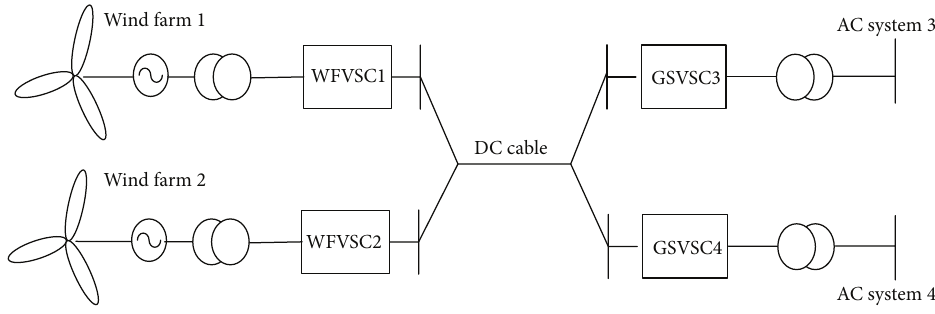
Figure 1: Four-terminal VSC-MTDC system connecting wind